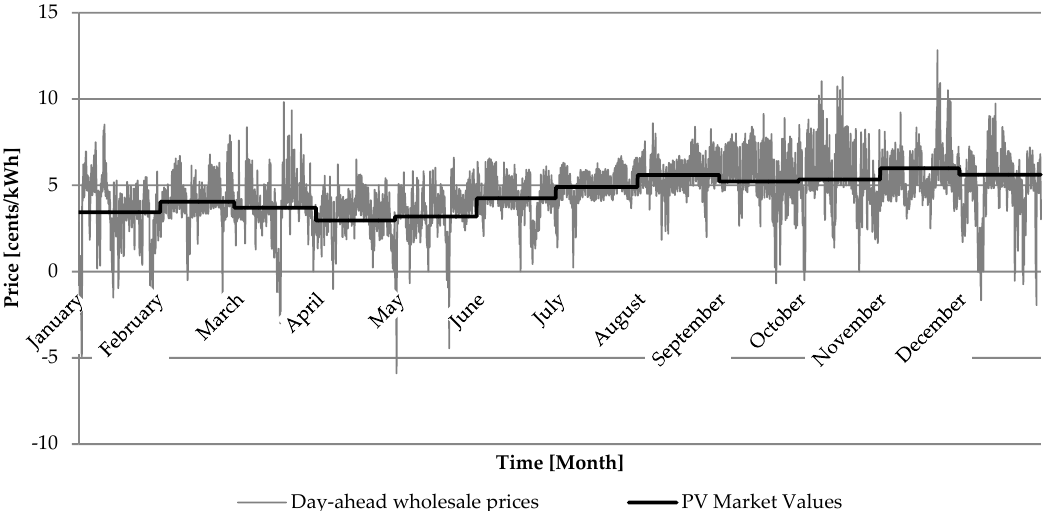
Figure A3. Day-ahead spot market prices and market values for the year 2018 (own presentation based on the data from [35,36]).